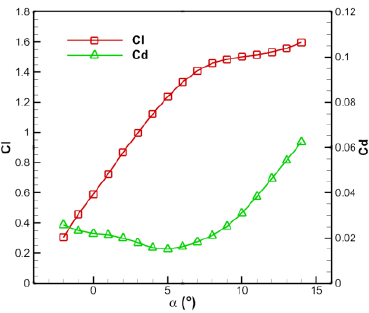
Figure 15. Aerodynamic curves of the stator of the 400 ducted fan.